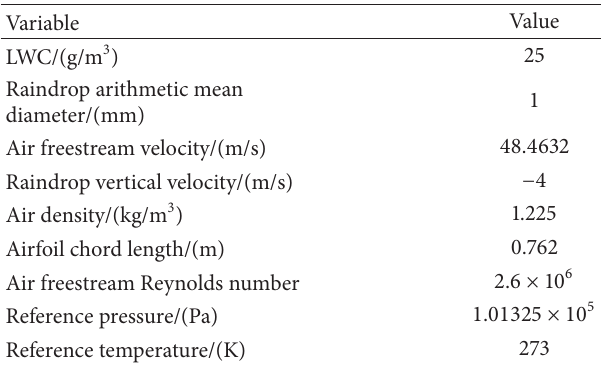
Table 2: Calculated rain